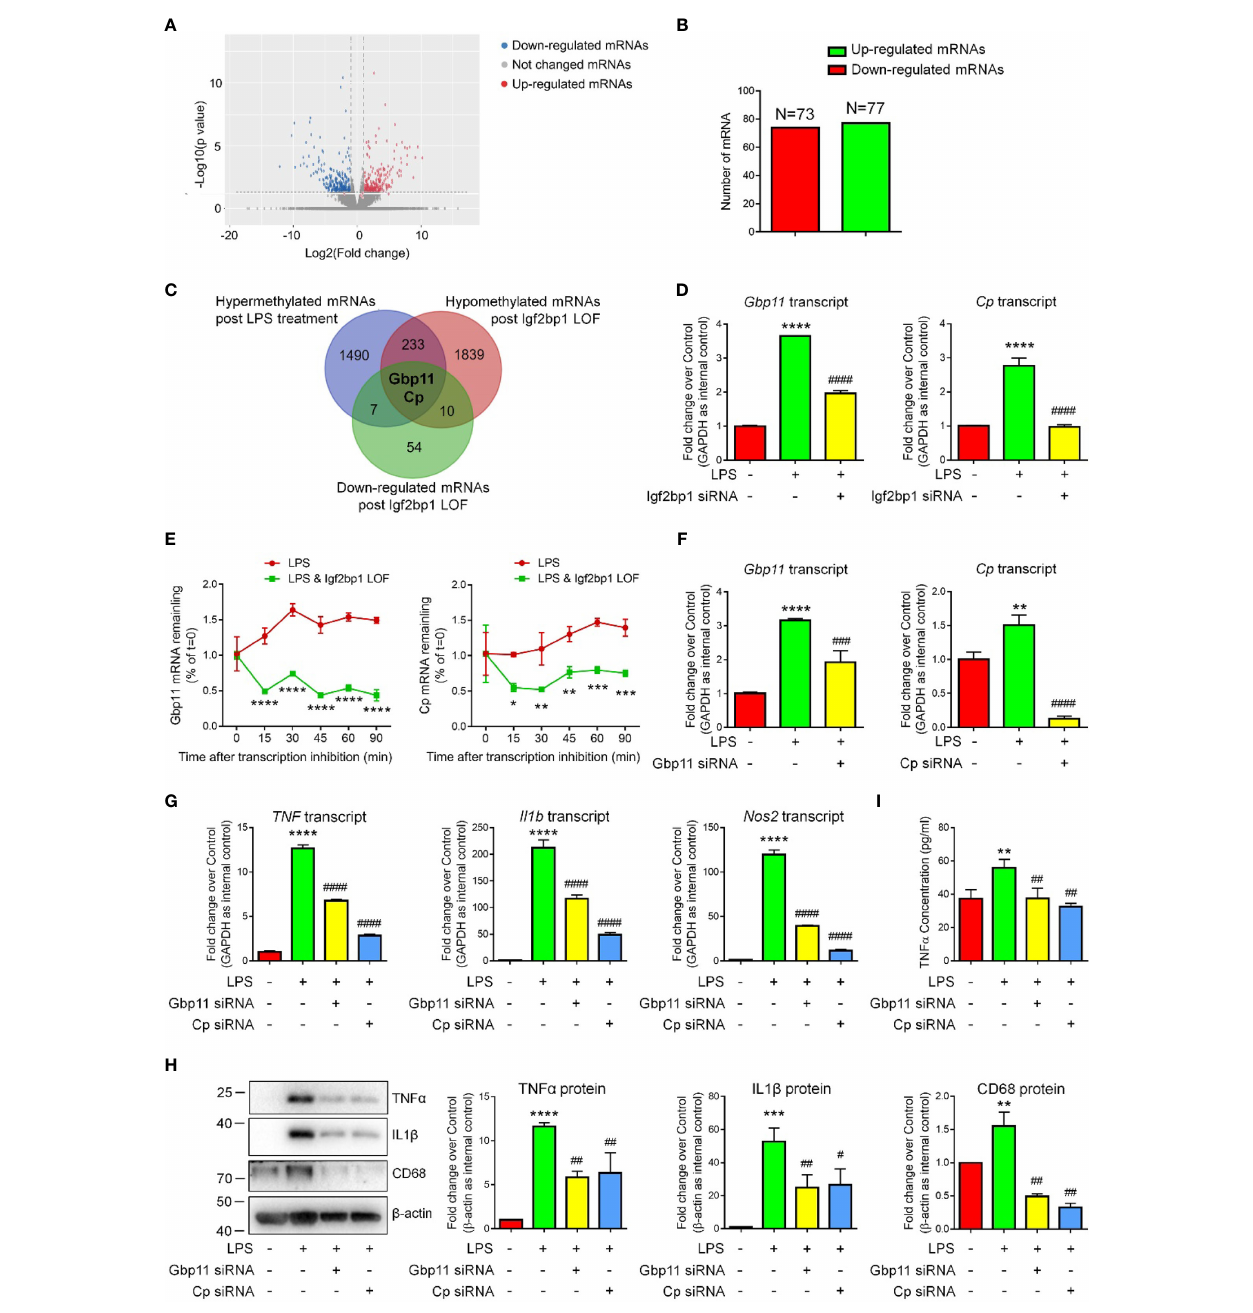
FIGURE 4 | Igf2bp1 regulates the in fl ammatory responses of microglia via stabilizing Gbp11 and Cp mRNAs. (A) Volcano plots showing the differentially expressed genes after knocking down Igf2bp1 expression in LPS-stimulated microglia. (B) The numbers of differentially expressed genes. (C) Venn diagrams for genes with m6A hypermethylation after LPS treatment, m6A hypomethylation post Igf2bp1 LOF, and reduced expression post Igf2bp1 LOF. (D) Expression of Gbp11 and Cp mRNAs in LPS-stimulated microglia after knocking down Igf2bp1 expression was determined by qRT-PCR. (E) Gbp11 and Cp mRNAs degradation in microglia treated with actinomycin D for the indicated times. (F) The knockdown ef fi ciency of both Gbp11 and Cp siRNA in LPS-stimulated microglia was determined by qRT- PCR. (G) Expression of TNF , Il1b , and Nos2 mRNAs after knocking down either Gbp11 or Cp expression in LPS-stimulated microglia was determined by qRT-PCR. (H) Expression of TNF a , IL1 b , and CD68 proteins after knocking down either Gbp11 or Cp expression in LPS-stimulated microglia was determined by western blotting. (I) The release of TNF a after knocking down either Gbp11 or Cp expression from LPS-stimulated microglia was determined by ELISA assay. Data were represented as mean ± s.d. from three independent experiments.*, **, ***, and **** denote p < 0.05, p < 0.01, p < 0.001, and p < 0.0001, respectively, in comparison with control microglia. #, ##, ### , and #### denote p < 0.05, p < 0.01, p < 0.001, and p < 0.0001, respectively, in comparison with LPS-stimulated